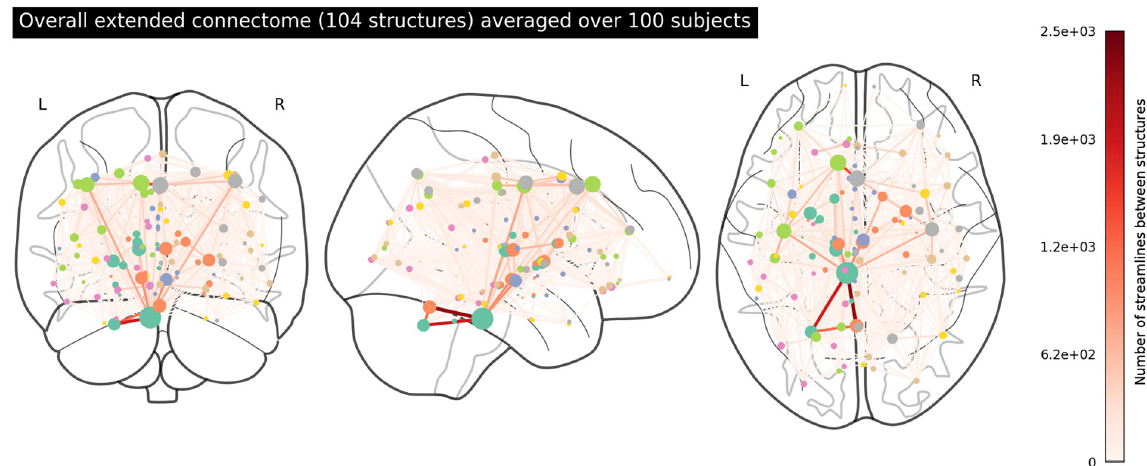
Fig 1. An overarching connectome featuring the 104 structures in the extended network. The strength of connections between structures (represented by the coloured nodes) is indicated by the colour, with darker red indicating more streamlines connecting two regions. Node size reflects the raw density of each node. Streamlines correspond to white matter fibre bundles. The full list of the 104 structures in this connectome can be found in Supporting information.